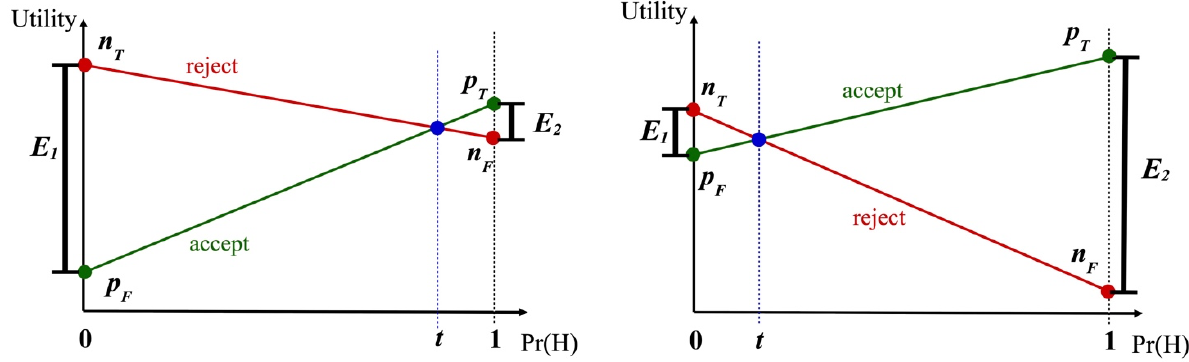
Figure 2. (a) (left) As false positives become relatively costlier (as E 1 / E 2 increases), applying a higher evidential standard to H maximizes expected utility—as reflected in the threshold, t , approaching Pr(H) = 1. (b) (right) As false negatives become relatively costlier (as E 2 / E 1 increases), applying a lower evidential standard to H maximizes expected